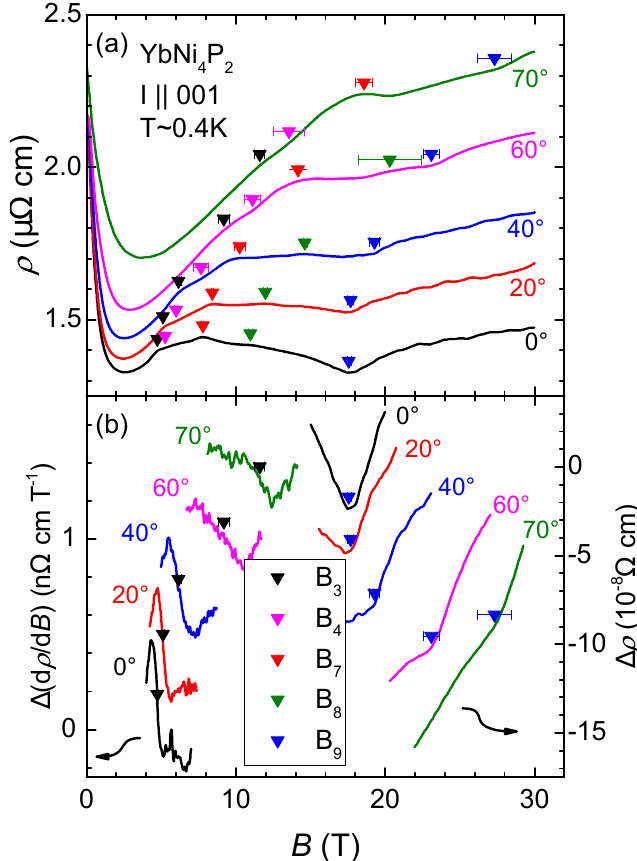
Figure 2: (a) c -axis magnetoresistance ρ for representative orientations. Labels in- zz dicate the polar angle φ between the magnetic field and the crystallographic (001) di- rection. Arrows indicate the position of Lifshitz transitions identified from the deriva- tive and constant background subtracted signal as shown in (b) and as described in the text. Data in (a) and (b) are offset for